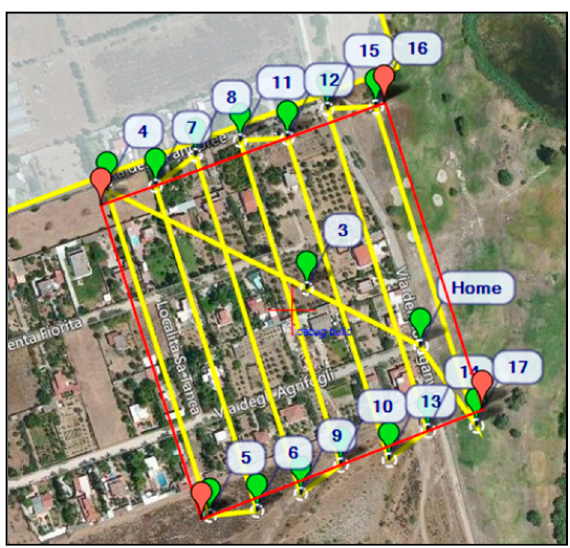
Figure 4. Area surveyed.